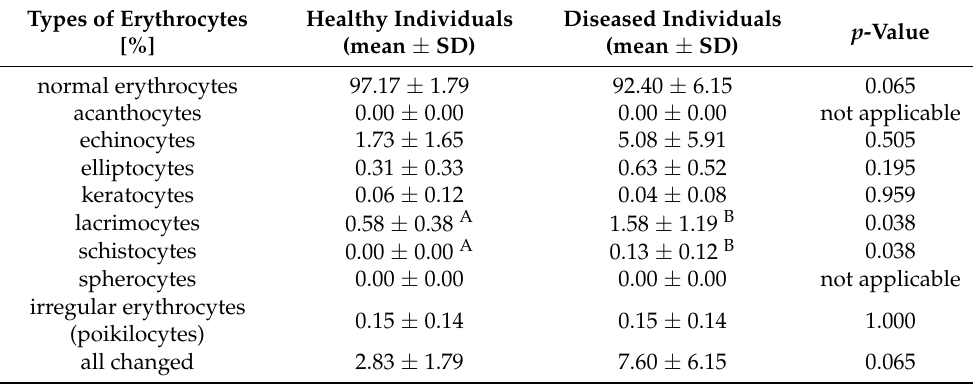
Table 2. Erythrogram results of healthy and diseased